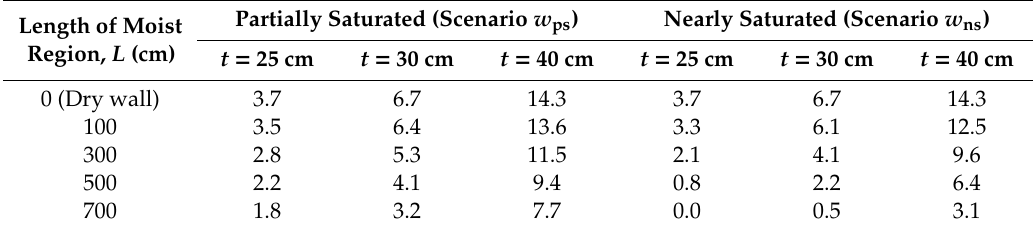
Figure 6. Pushover curves for Scenario w ns . Table 2. Out-of-plane lateral strength (kN) for all the cases.